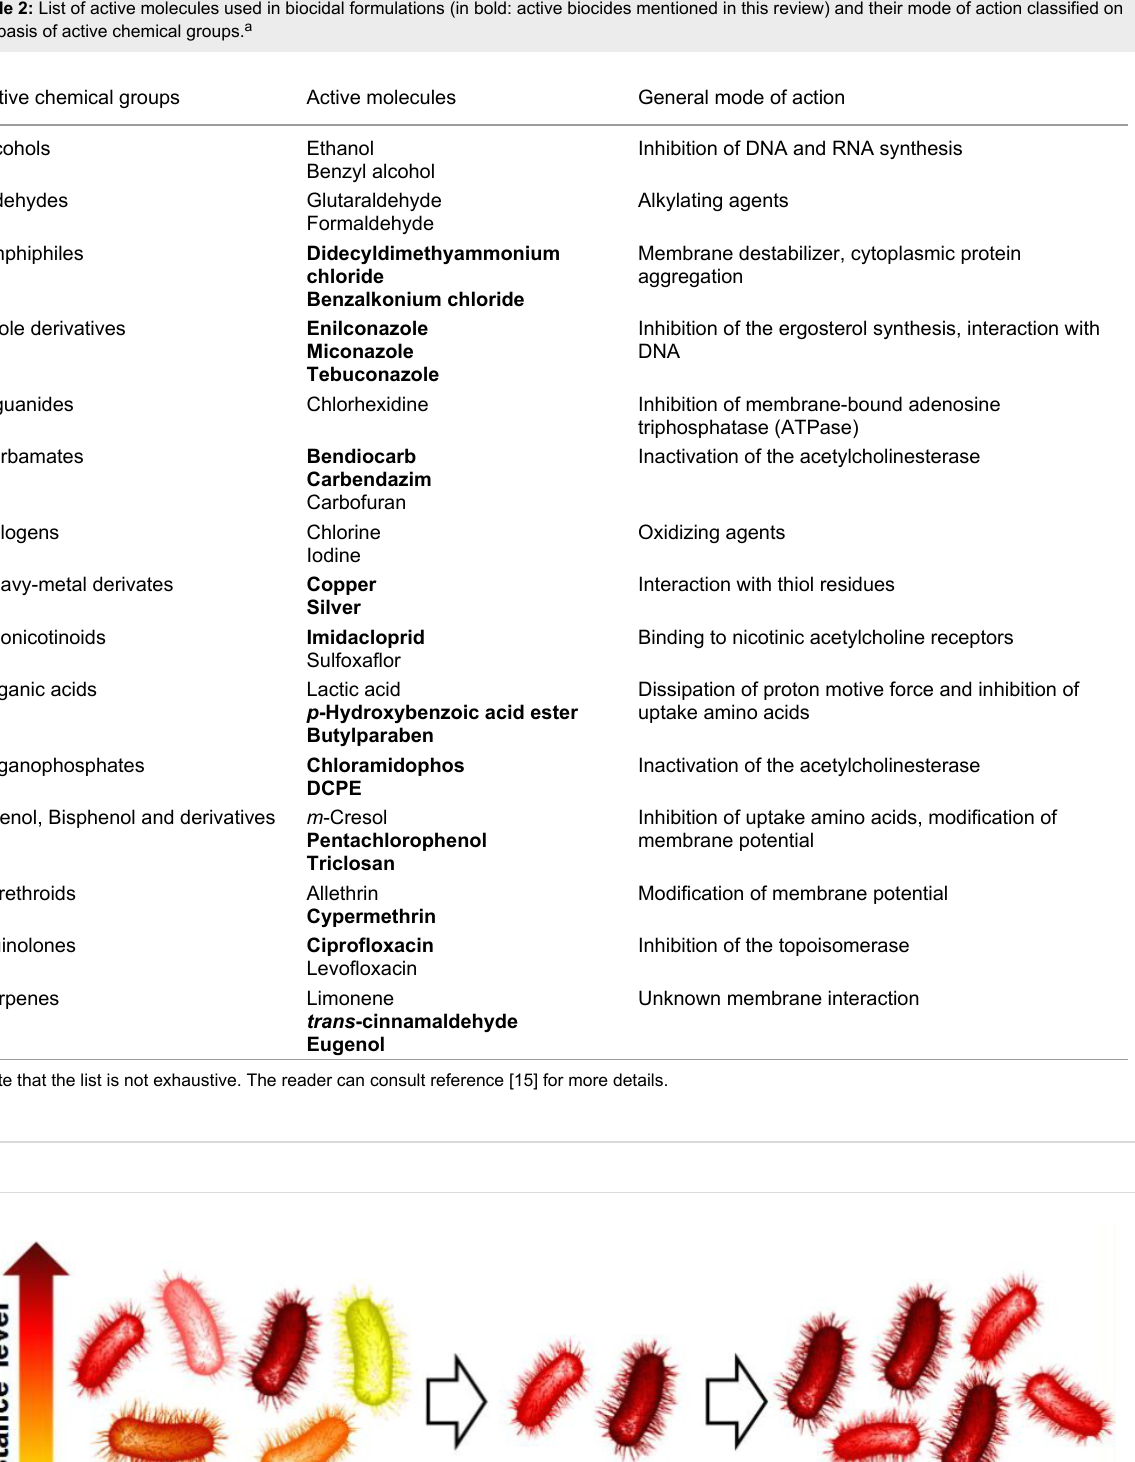
Table 2: List of active molecules used in biocidal formulations (in bold: active biocides mentioned in this review) and their mode of action classified on the basis of active chemical groups. a